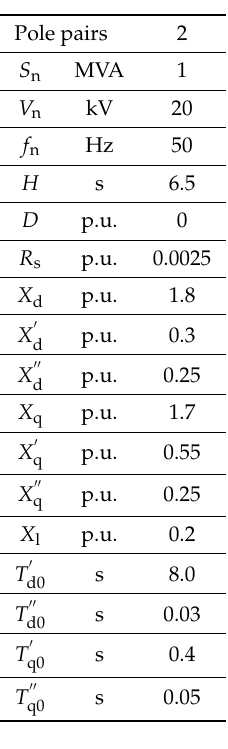
Table A4. Characteristics of the synchronous